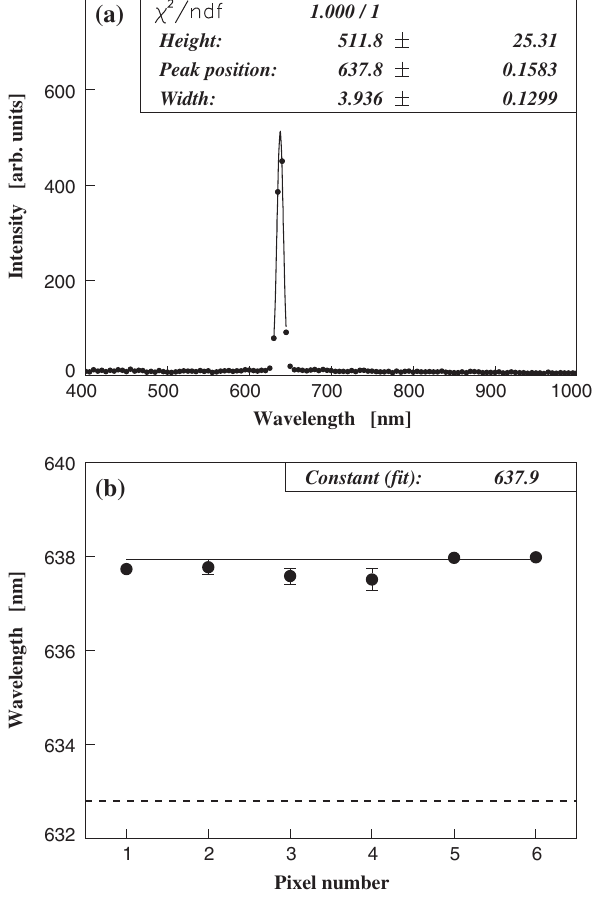
FIG. 10. Observed spectra for the red HeNe laser after applying thepixelsensitivitycalibration.(a)Spectrummeasuredatthecentral pixel of the image sensor. The black dots represent measurements at intervals of 5 nm, and the solid curve is the result of fitting with a Gaussian function around the peak. The numbers given at the top describethefittingresults,wheretheerrorswerecalculatedsuchthat the ratio of χ 2 to the number of degrees of freedom (ndf) is unity. (b) Fitted peak positions at six different pixels on the image sensor. The solidlineisthe constant fittingresult obtainedforthe six points, and the exact value of this fitting is given at the top part of the plot. Thehorizontal dashedlineindicates thewavelength ofthe redHeNe laser (632.8 nm).